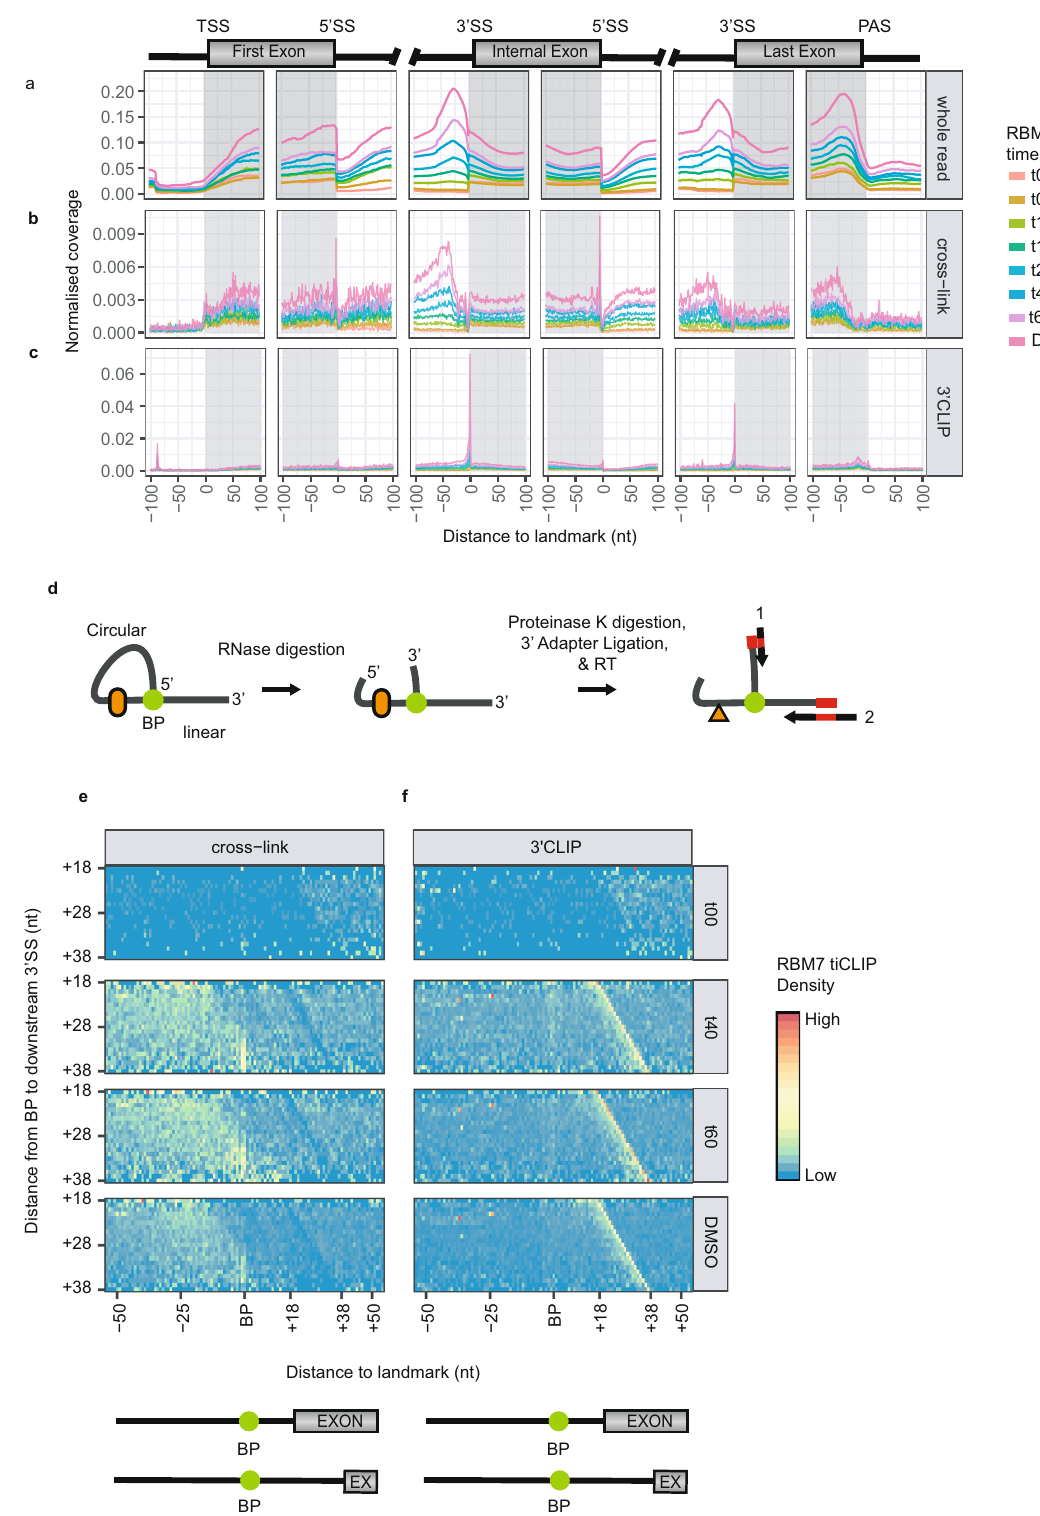
Fig. 5 | RBM7 is recruited to introns before debranching but after the second transesteri fi cation step. a – c Normalised RBM7 coverage pro fi les as in Fig. 3d, e, butacrossmulti-exonicTUsanddisplayingthewholeread( a ),thecross-linksite( b ) or the 3 ′ CLIP site ( c ). 11249 TUs were used in this analysis. d A schematic repre- sentation of the two possible cDNA truncation sites upon reverse transcription of a cleaved lariat intron. RT primer ‘ 1 ’ indicates cDNA synthesis from within the lariat, whereas RT primer ‘ 2 ’ indicates cDNA synthesis from the linear part of the lariat. Cross-linked protein is represented by orange cartouche, whereas the orange